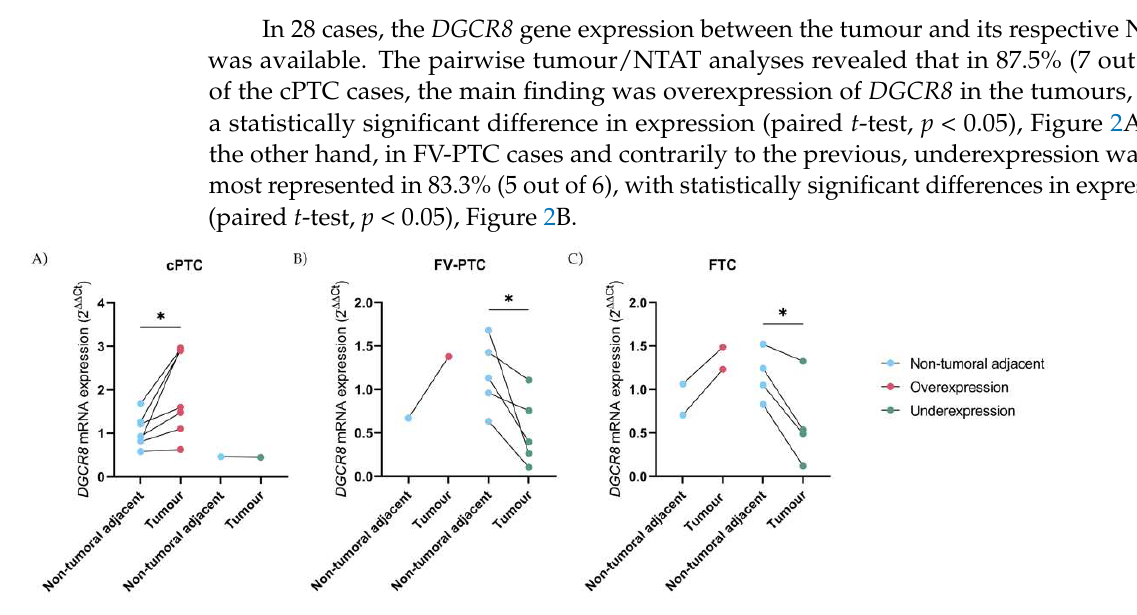
Table 2. Score values of DGCR8 immunoexpression in the different histotypes.